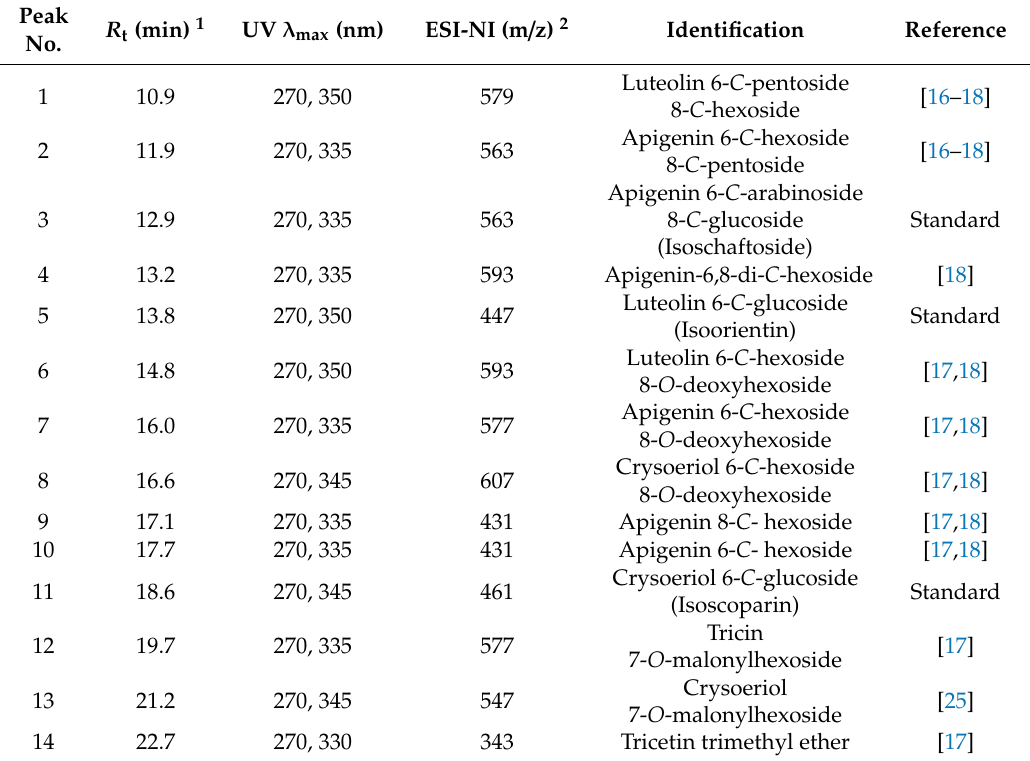
Table 1. UV–VIS absorption maxima and main electrospray ionization mass spectrometry (ESIMS) peaks of the flavonoids tentatively identified in the wheat sprout